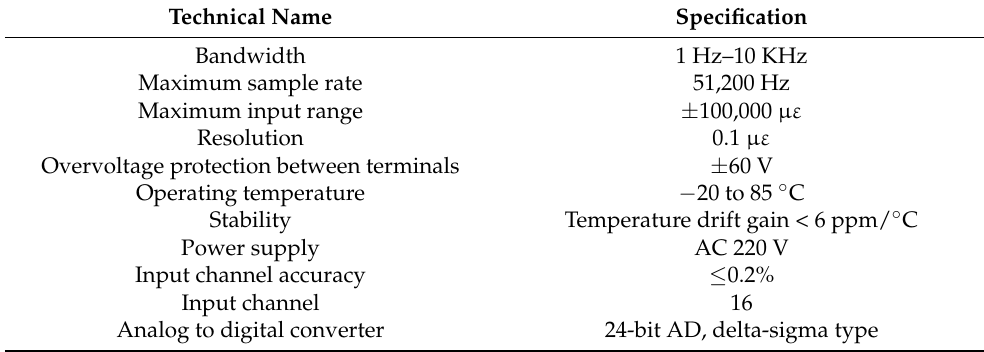
Table 4. Collector primary